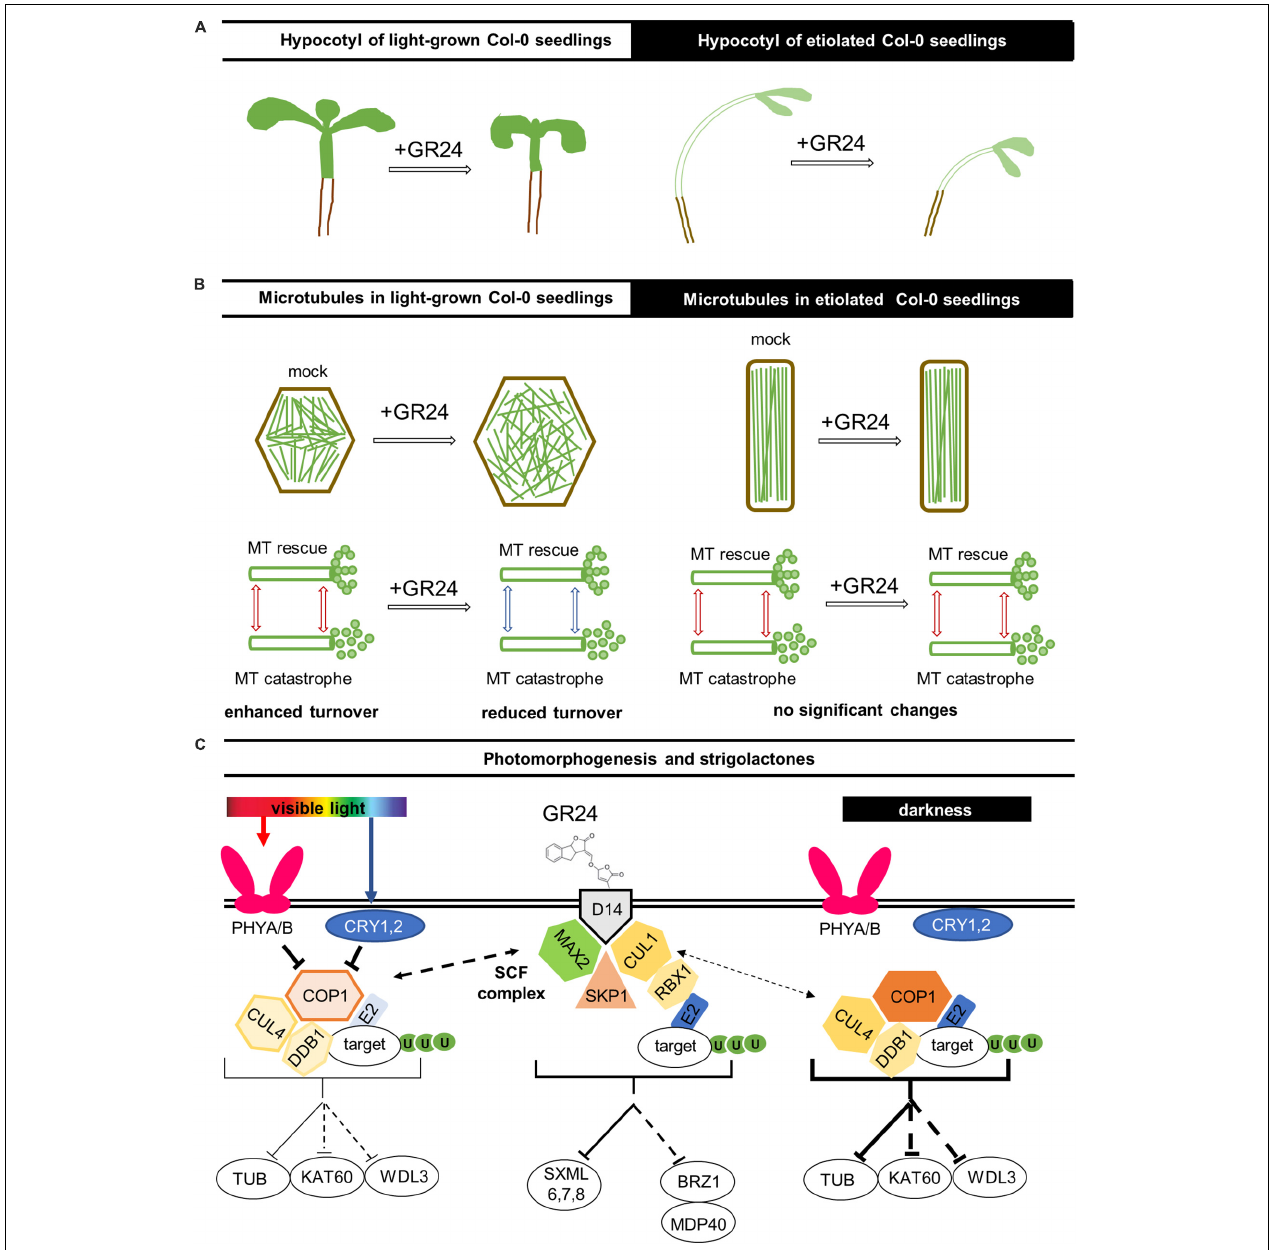
FIGURE 9 | Hypothetical model of light-dependent strigolactone effects on microtubules in Arabidopsis . (A) Regarding the overall hypocotyl phenotype, the strigolactone treatment inhibits hypocotyl growth and causes radial expansion of epidermal cells in light-grown seedlings; however, the dark-grown ones were more resistant to the changes of strigolactone content. (B) In light-grown seedlings the treatment with GR24 leads to changes in microtubule organization and dynamics: (1) more pronounced randomization of cortical microtubule array; (2) increased microtubule bundling and stabilization; (3) reduced microtubule dynamicity and likely promoted microtubule longevity. On the other hand, no significant microtubule changes were noted after similar treatments in etiolated seedlings as the trend is to maintain highly organized systems of parallel microtubules. (C) Red and blue lights are perceived by PHYTOCHROMES A and B (PHYA/B) and CRYPTOCHROMES 1 and 2 (CRY1/2), respectively, which inhibit the E3 ligase complex consisting of CONSTITUTIVE PHOTOMORPHOGENIC 1 (COP1), CULLIN4 (CUL4), and DAMAGE-BINDING PROTEIN 1 (DDB1). This E3 ligase complex directs the transfer of ubiquitin (U) from an E2 ligase onto targets, which generally leads to their degradation by proteasomes. Bellow the complex, known (solid line) and putative (dotted line) targets are shown, specifically TUBULIN (TUB), KATANIN 60 (KAT60), and WAVE-DAMPENED 2-LIKE 3 (WDL3). The function of this E3 ligase complex is more prominent under darkness when it is not inhibited by PHYA/B and CRY1/2. It has been previously proposed that COP1 might be regulated by the SKP1-CULLIN-F-BOX (SCF) complex containing an F-box protein MORE AUXILARY GROWTH 2 (MAX2). This SCF complex consists of MAX2, hydrophobic scaffold protein CULLIN1 (CUL1), S-phase kinase-associated protein 1 (SKP1), and E3 ubiquitin-protein ligase RING-BOX1 (RBX1); it also functions as an E3 ligase; known (solid line) and putative (dotted line) targets are shown, namely, SUPPRESSOR OF MORE AXILLARY GROWTH2-LIKE (SMXL) proteins and transcriptional repressor BRASSINAZOLE-RESISTANT 1 (BZR1), which is involved in the regulation of microtubules via the MICROTUBULE DESTABILIZING PROTEIN40 (MDP40). SCF complex is activated by artificial strigolactones GR24+ binding to an α / β -hydrolase D14, strigolactone-specific receptor.